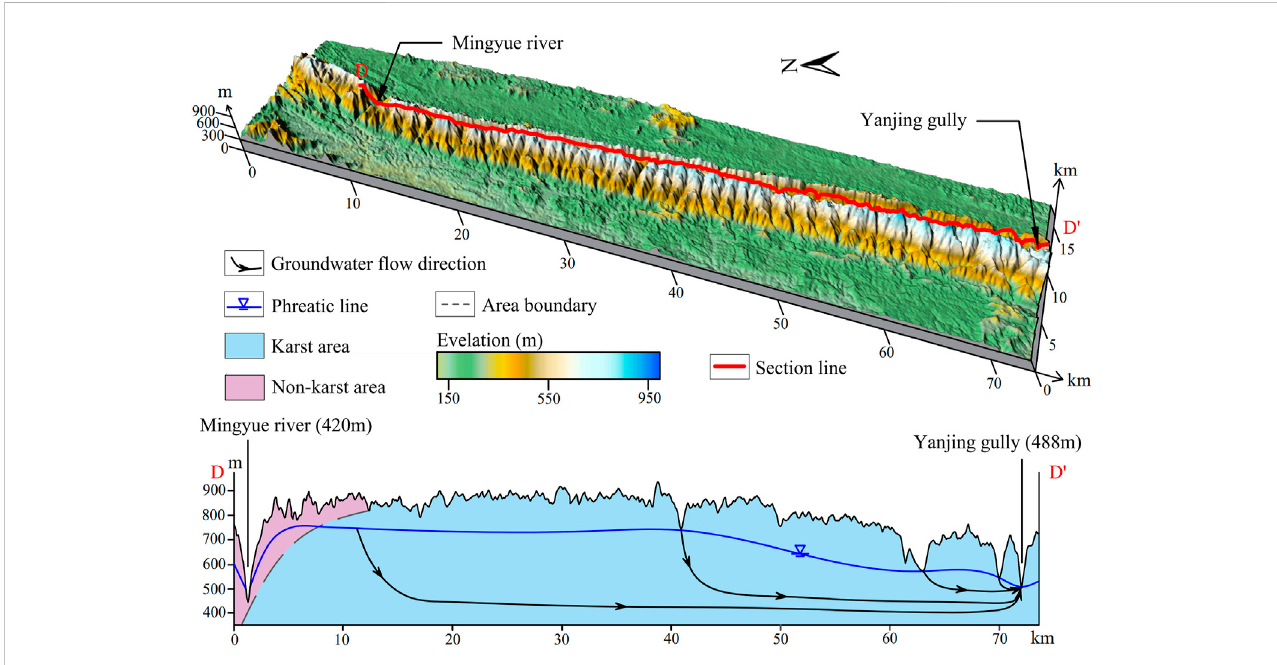
FIGURE 7 Karst water circulation pattern in north section of Mingyueshan.